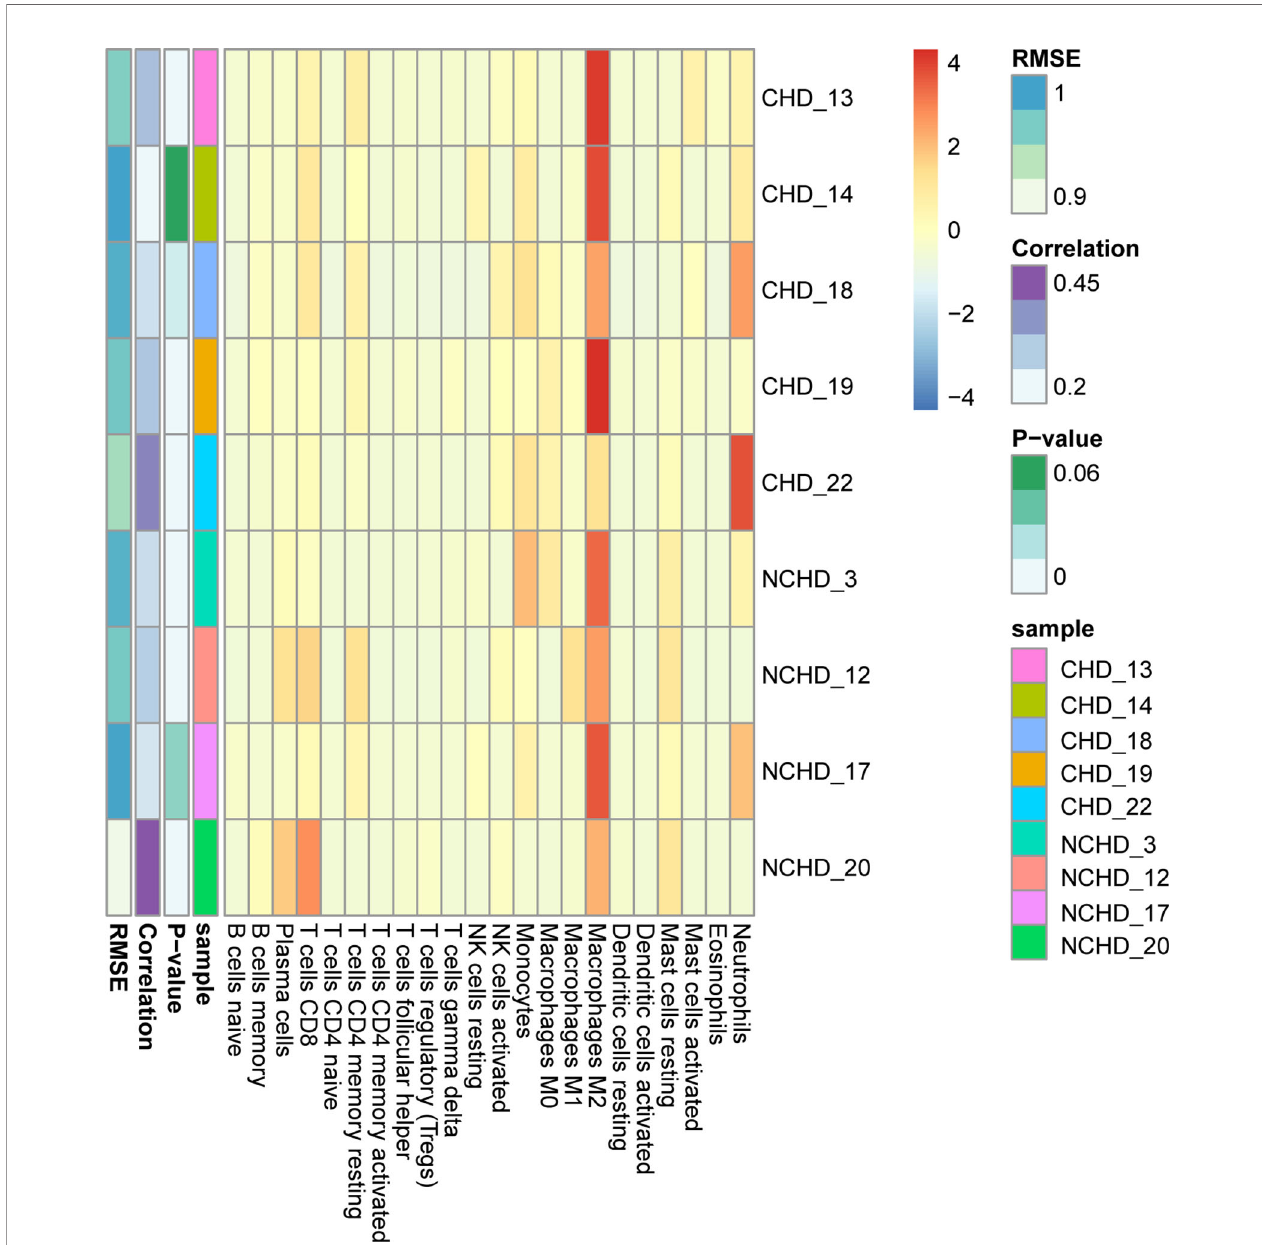
FIGURE 5 | Distinction of in fi ltrating immune cell subpopulations and levels between CHD/NCHD